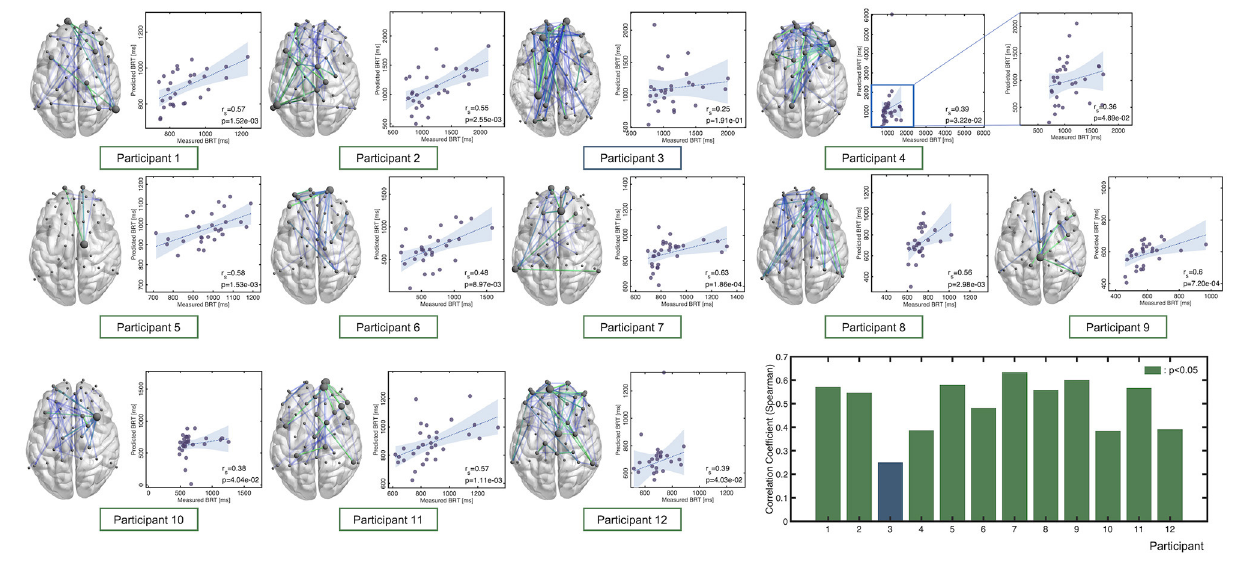
indicated that the regression model differed between individuals in their chosen FC edges and the number of edges. each model. Figure 6 shows a dendrogram of the FC patterns of the 11 individual models. Through clustering, the 11 individual models were classified into 5 clusters (the red line drawn